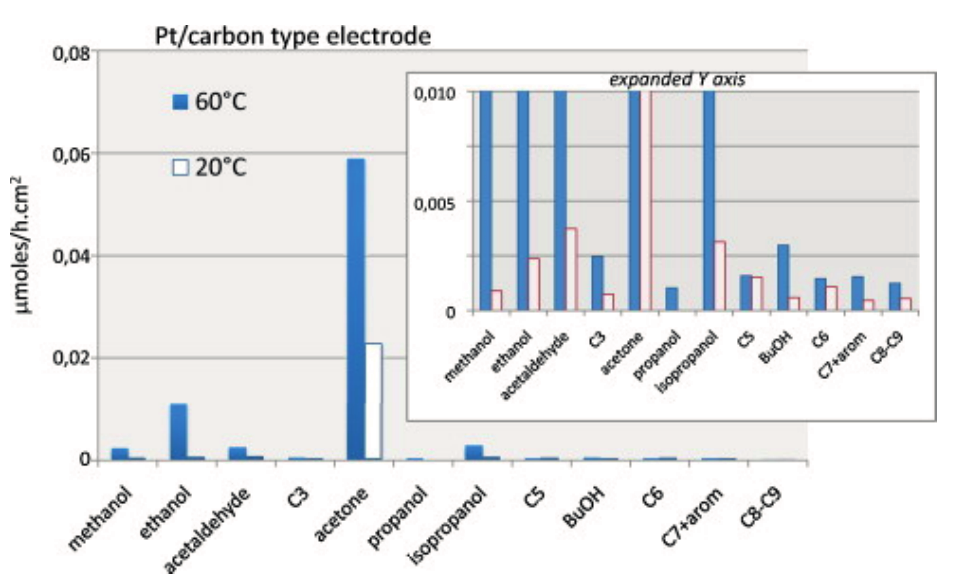
Figure 29. Temperature effect in gas phase CO 2 electro-reduction on 10% Pt/Carbon/ Nafion117 GDM electrode (reproduced from [333] with permission of